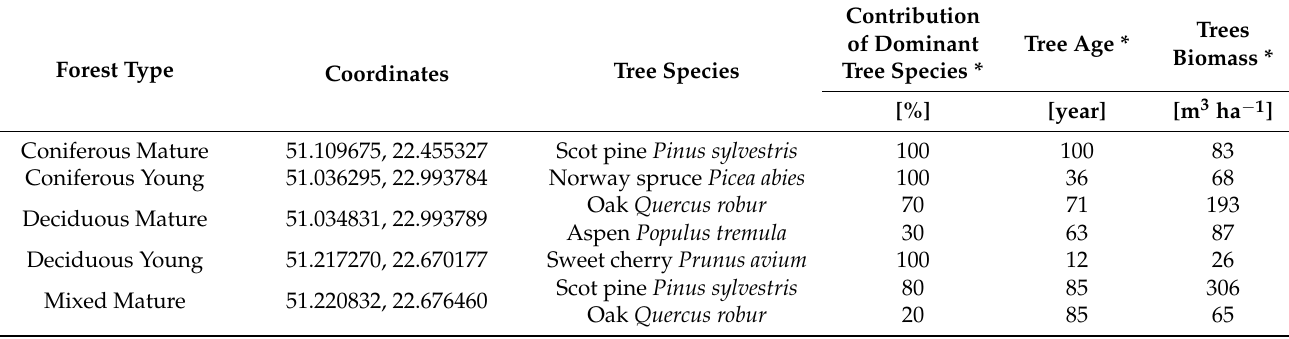
Table 1. Basic characteristic of the forests